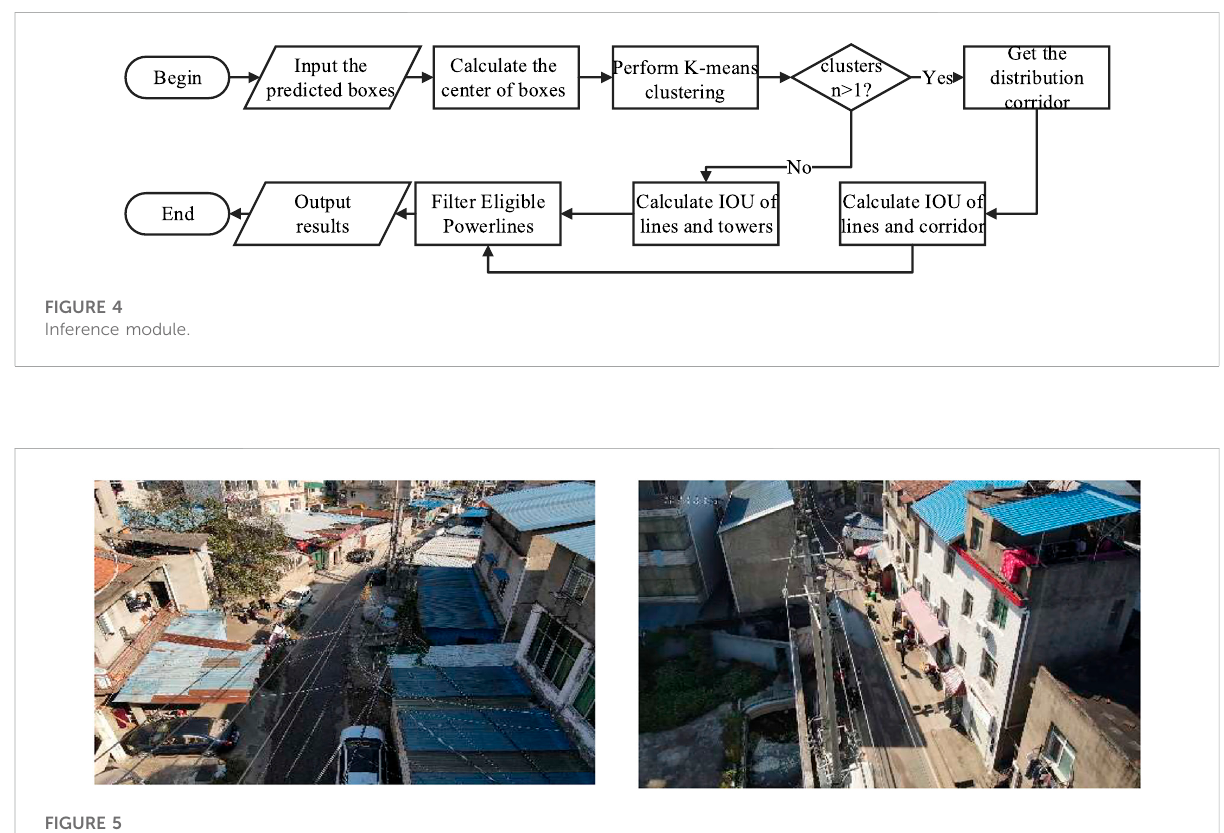
FIGURE 5 Images of low-voltage distribution network transmission lines.